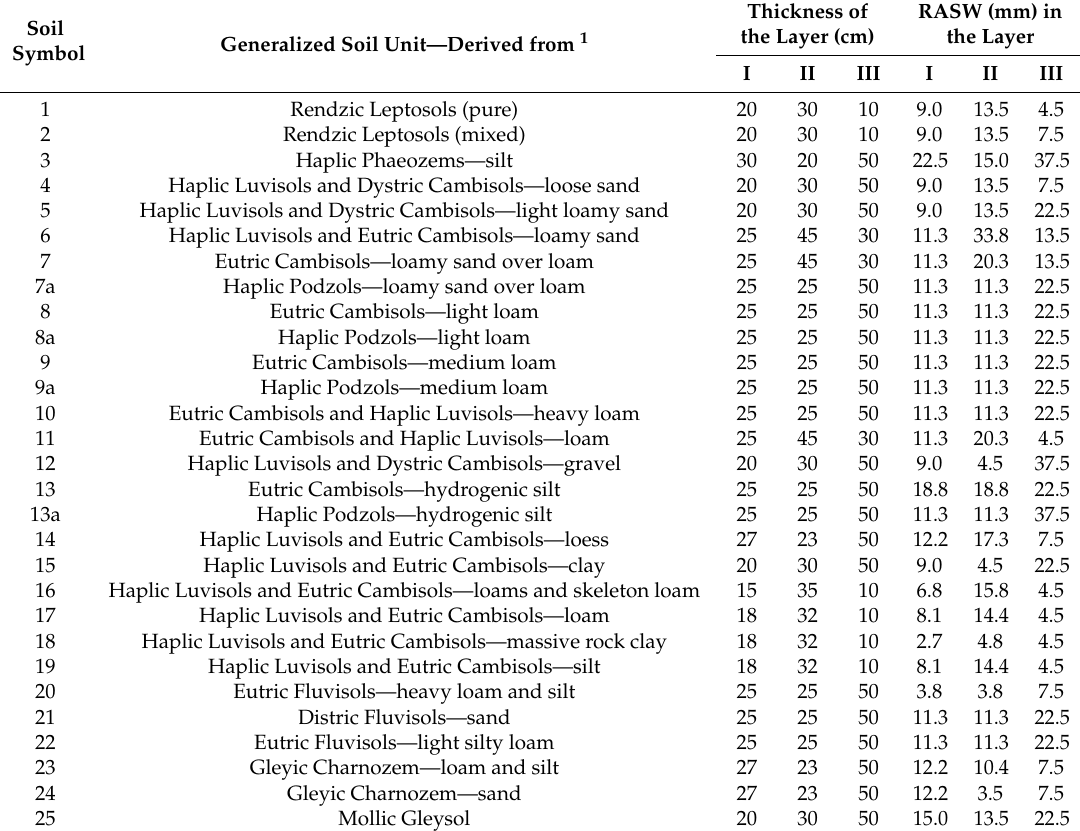
Table 1. Soil layer thickness and readily available soil water RASW .